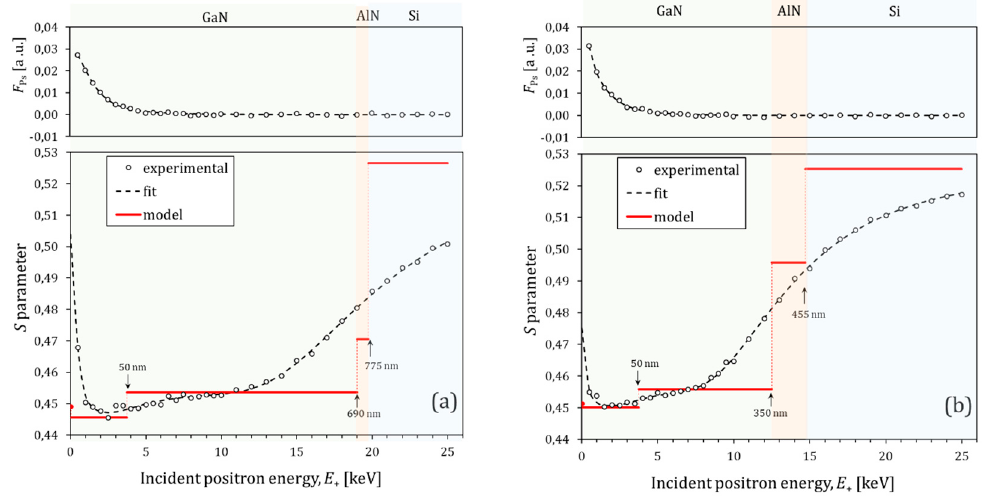
Figure 5. Plotted depth profiles S ( E + ) of ( a ) GaN700 / Si and ( b ) GaN300 / Si. The experimental errors are in the order of the experimental point size. The stairs represent the best parameters obtained by the fit of a 4-layer model to the experimental data by the VEPFIT software. The upper part of figure is the experimental data and the best fit of the relative Ps fraction, F Ps ( E + ).